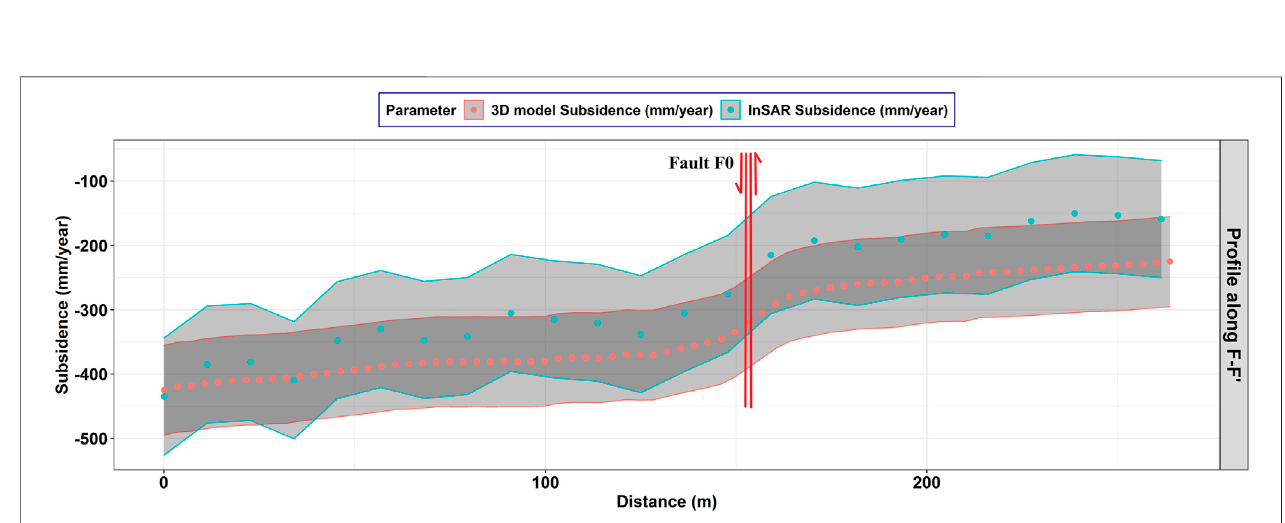
FIGURE 8 | Land subsidence pro fi les of FDM model and InSAR result along F-F ′ .